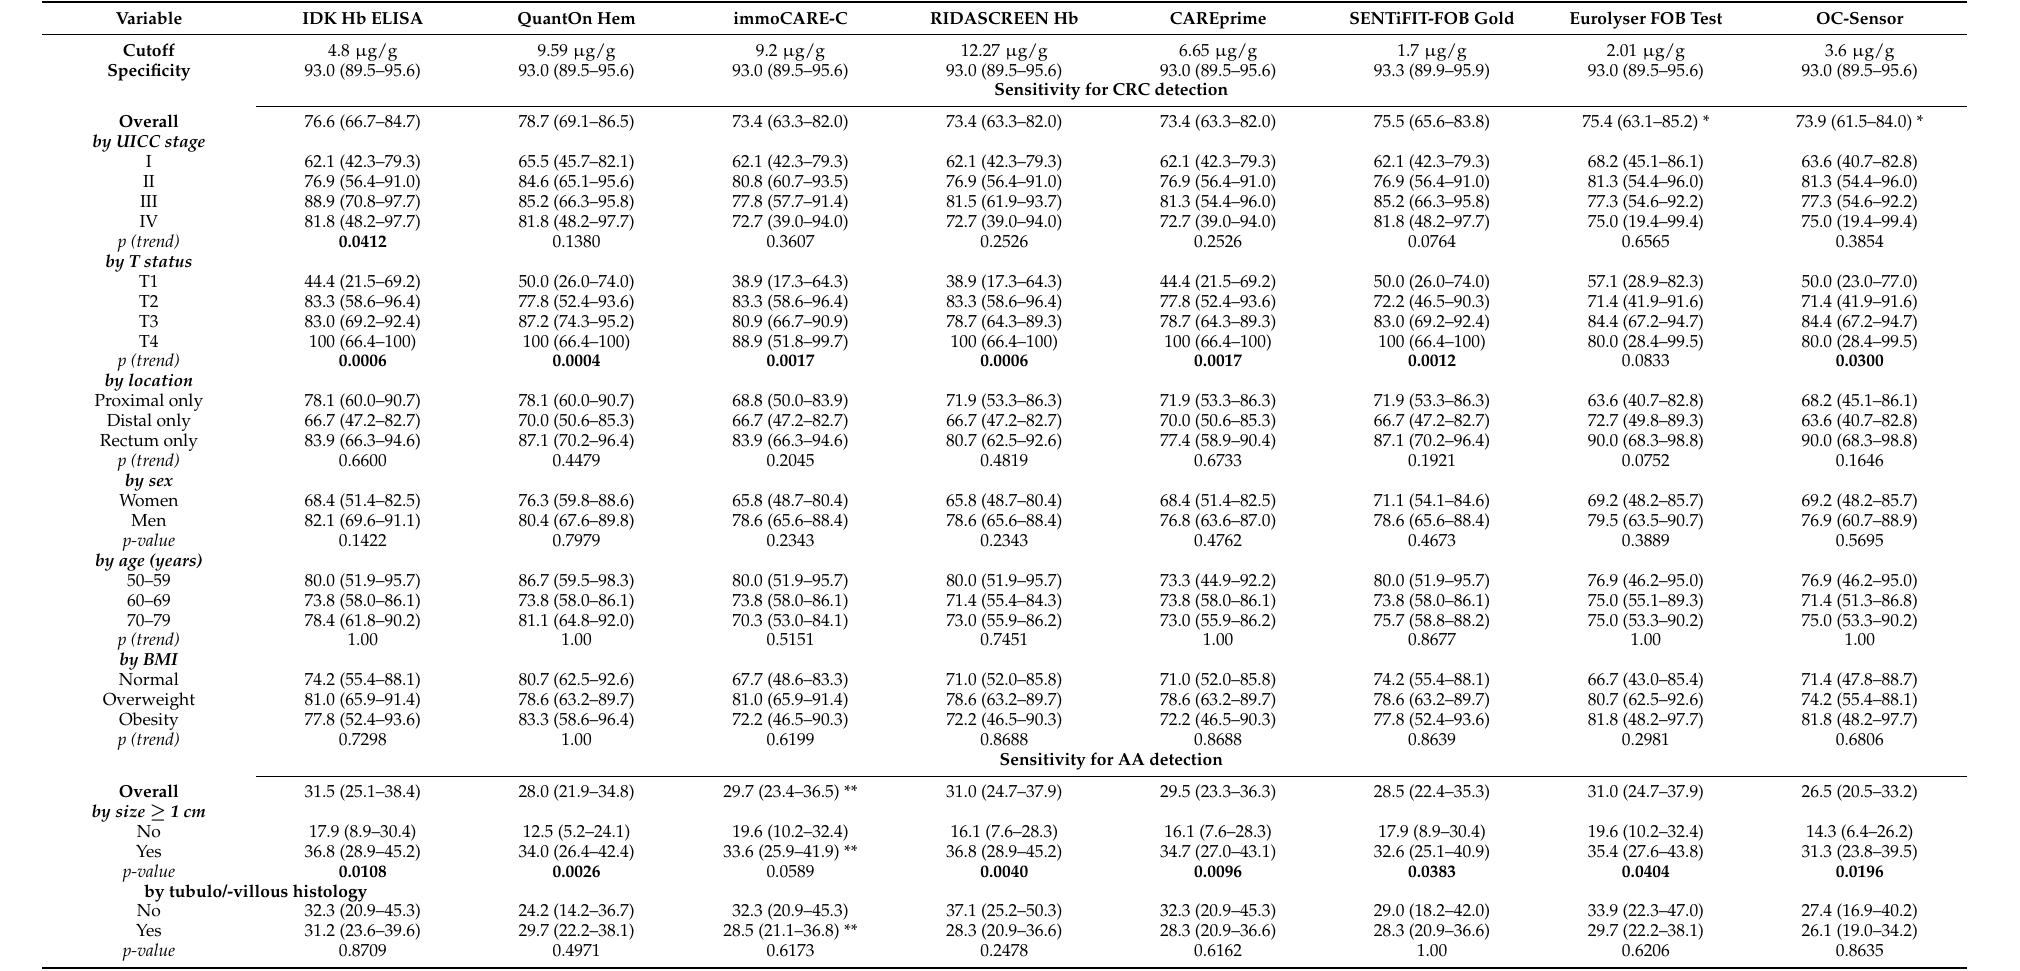
Table 4. Sensitivity (% (95%CI)) at adjusted cutoffs yielding 93%